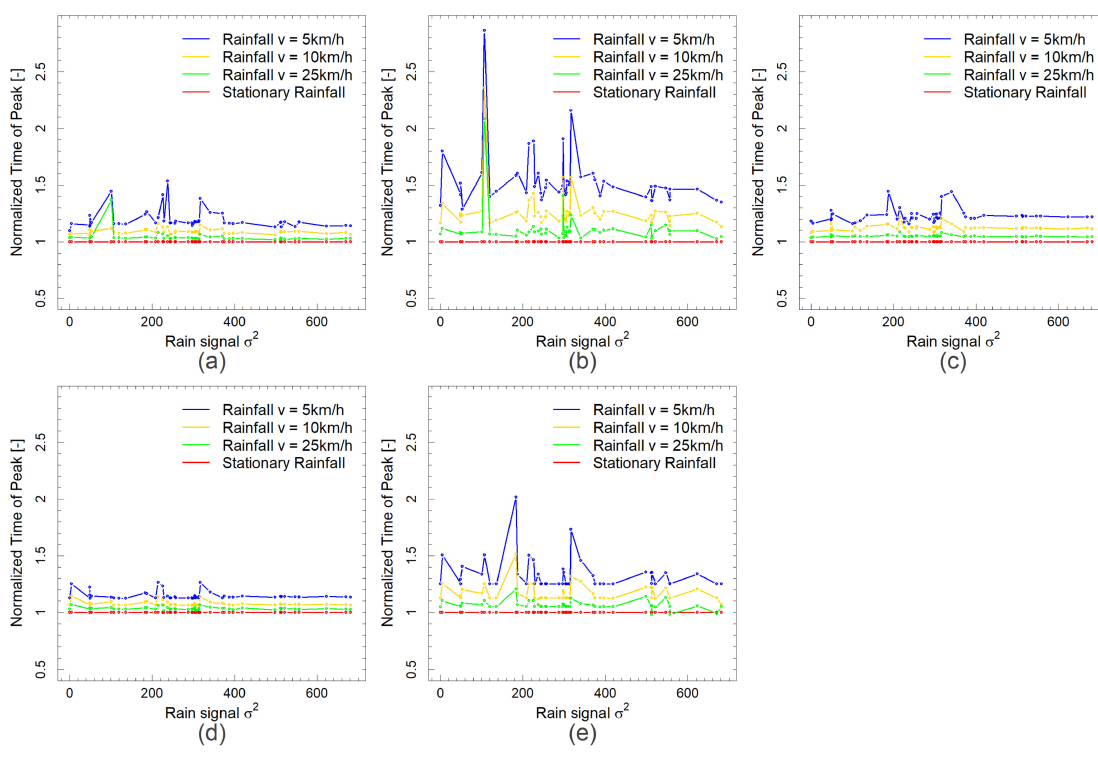
Figure 9. Normalized time of peak discharges by the time of peak discharge of the stationary scenario for rains under the stationary and moving setups with velocities v = 5 km/h, v = 10 km/h, v = 25 km/h with a direction from west to east at all measuring points A ( a ), B ( b ), C ( c ), D ( d ), E ( e